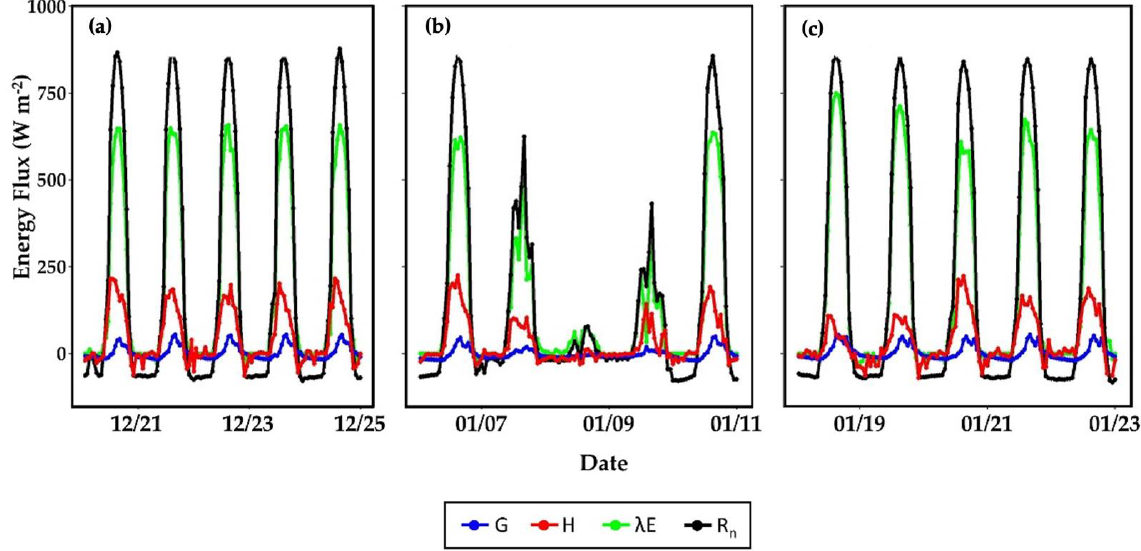
Figure 5. Diurnal trend of energy fluxes during three 5 – day periods at site S1 in 2018 – 2019. The fluxes include soil heat flux (G), sensible heat (H), latent heat ( λ E), and net radiation (Rn). ( a ), ( b ), and ( c ) represents the first, second, and third field campaigns, respectively.